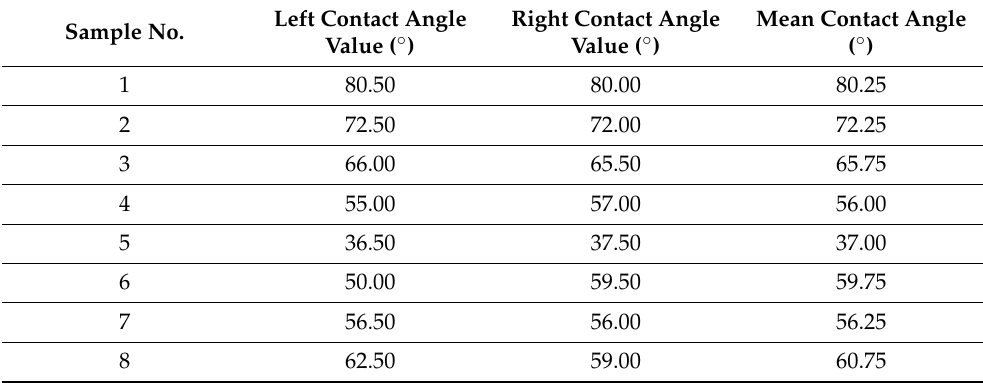
Figure 3. The contact angle between the graphite surface and distilled water before and after modification with CTAC. Table 3. Measured contact angles between distilled water on the graphite surface before and after modification with CTAC.